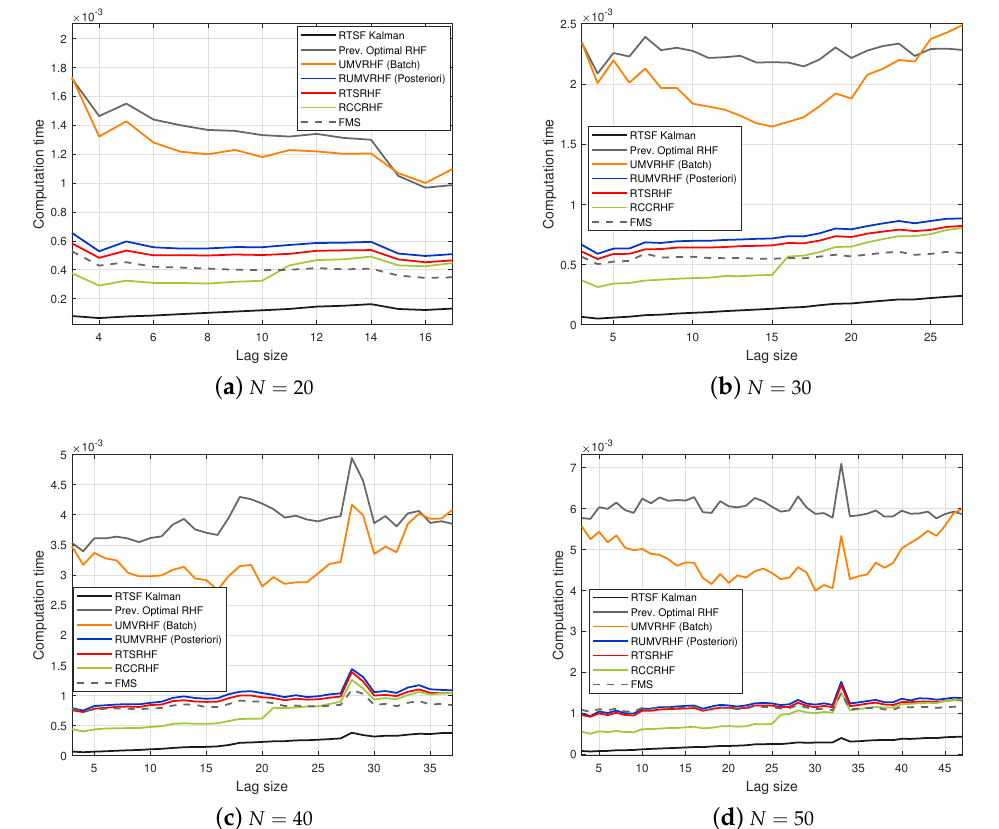
Figure 7. Time-averaged computation time with respect to the horizon lengths and lag sizes. Figure 8 and Table 6 present estimation errors and time averaged values of RMSE errors of smoothers for 200 ≤ k ≤ 350. In addition, the average computation times of RHF smoothers are presented in Table 7.